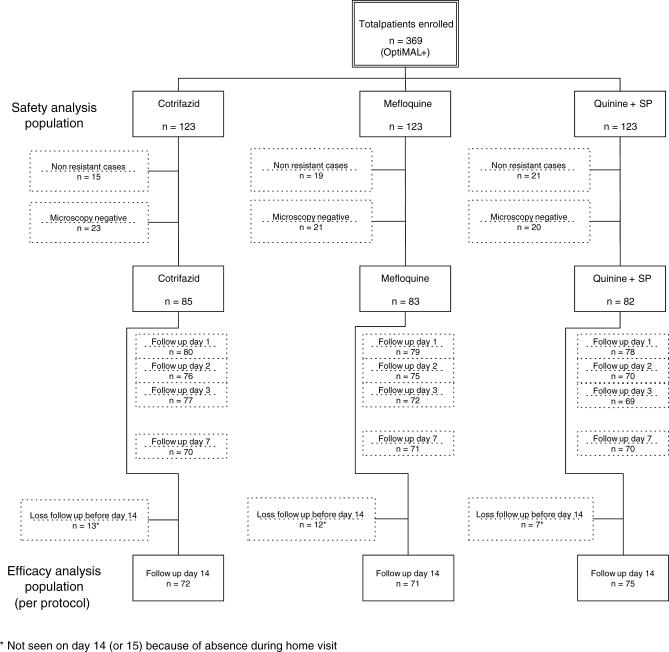
Participant Flow